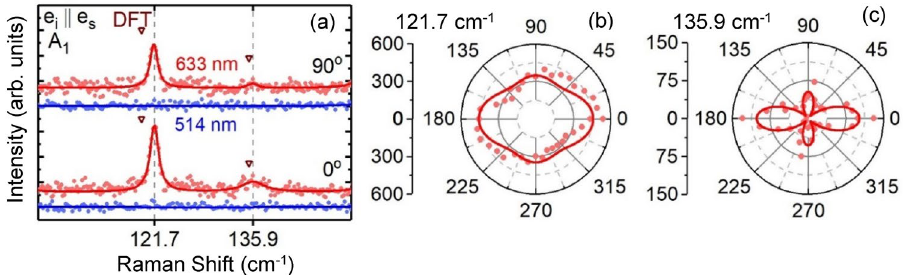
Figure 3. ( a ) Raman spectra for two peaks at angles of 0°, 90° for the parallel polarization configuration with 633 nm excitation (red lines) and 514 nm (blue lines) excitation. Dark red triangles mark the calculated modes utilizing Density Function Theory. ( b , c ) Polar plots of the Raman modes at 121.7 cm −1 and 135.9 cm −1 respectively using 633 nm